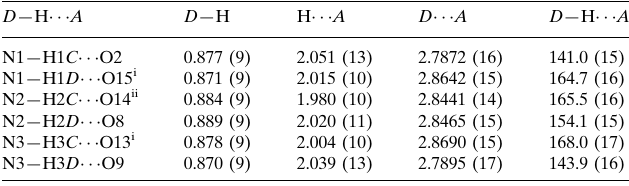
Hydrogen-bond geometry (A˚ , (cid:4)